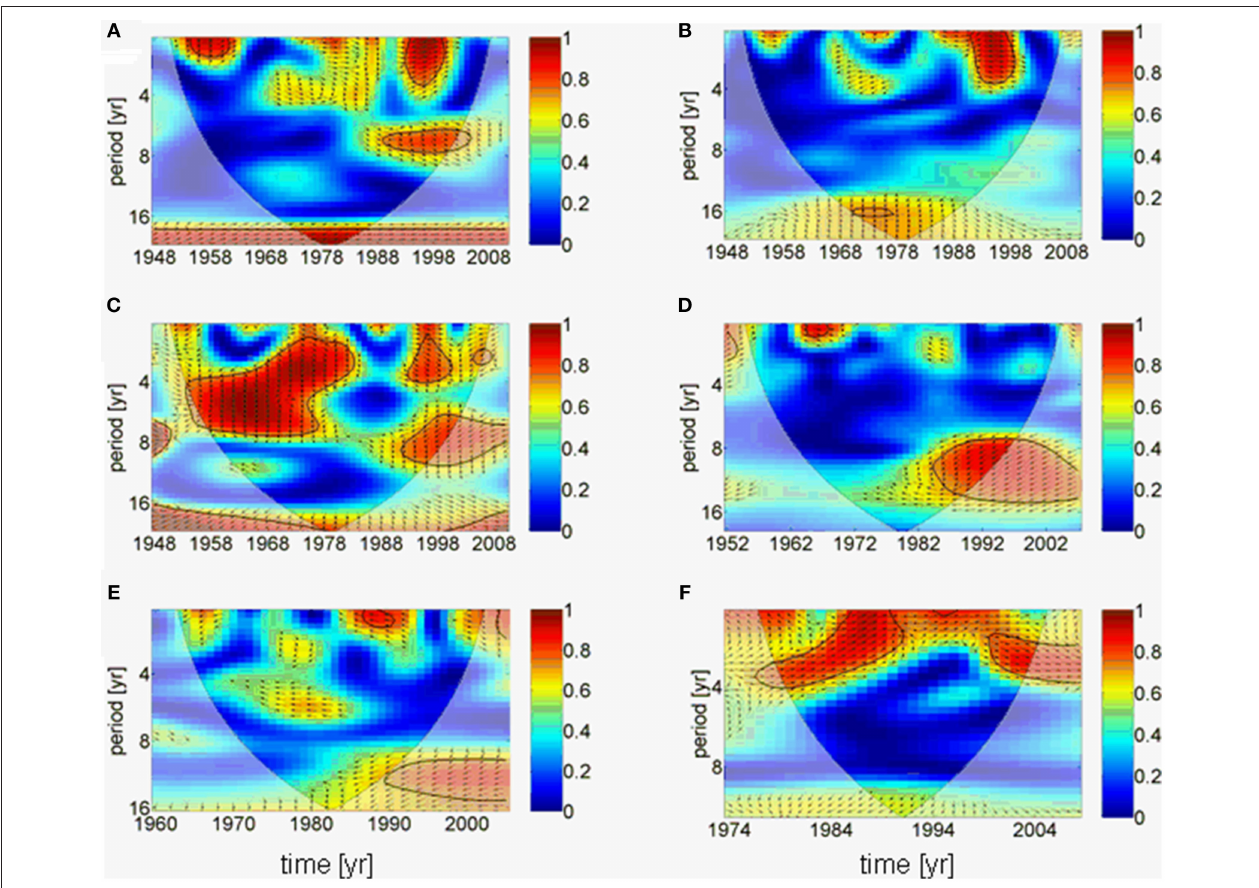
FIGURE 5 | Results of wavelet coherence and phase between different time series as function of time. Contours are wavelet squared coherencies. The vectors indicate the phase difference between time series (a horizontal arrow pointing from left to right signifies in phase and an arrow pointing vertically upward means the second series lags the first by 90 ◦ , i.e., the phase angle is 270 ◦ ). The thick black line is the 5% significance level using the red noise model and the opaque area indicates the cone of influence. (A) AMO and precipitation, (B) AMO and cumulative river runoff, (C) precipitation and cumulative river runoff, (D) cumulative river runoff and salinity, (E) salinity and zooplankton spring biomass, (F) zooplankton spring biomass and herring weight. All wavelets are based on annual averaged time